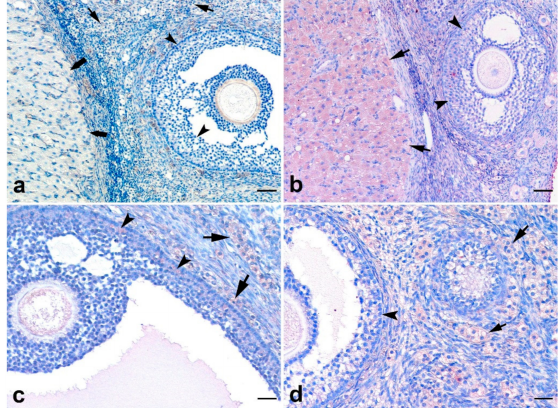
Figure 7. AMHRII immunopositivity in the feline ovary. ( a ) negative control, AMHRII negative luteal cells in corpus luteum (thick arrows), interstitial luteal cells (arrows) and granulosa cells of follicle (arrow heads); ( b ) AMHRII immunopositivity in granulosa cells of early antral follicles (arrow heads) and corpus luteum (thick arrows); ( c ) AMHRII immunopositivity in mural granulosa cells of large antral follicles (arrow heads) and interstitial luteal cells (arrows); ( d ) AMHRII immunopositivity in granulosa cells (arrow head) and interstitial luteal cells (arrows). SABP immunostaining, AEC chromogen, Mayer’s hematoxylin counterstaining, ( a – c ) × 140, ( d ) × 280. Scale bar: ( a , b ) = 60 µ M and ( c , d ) = 30 µ